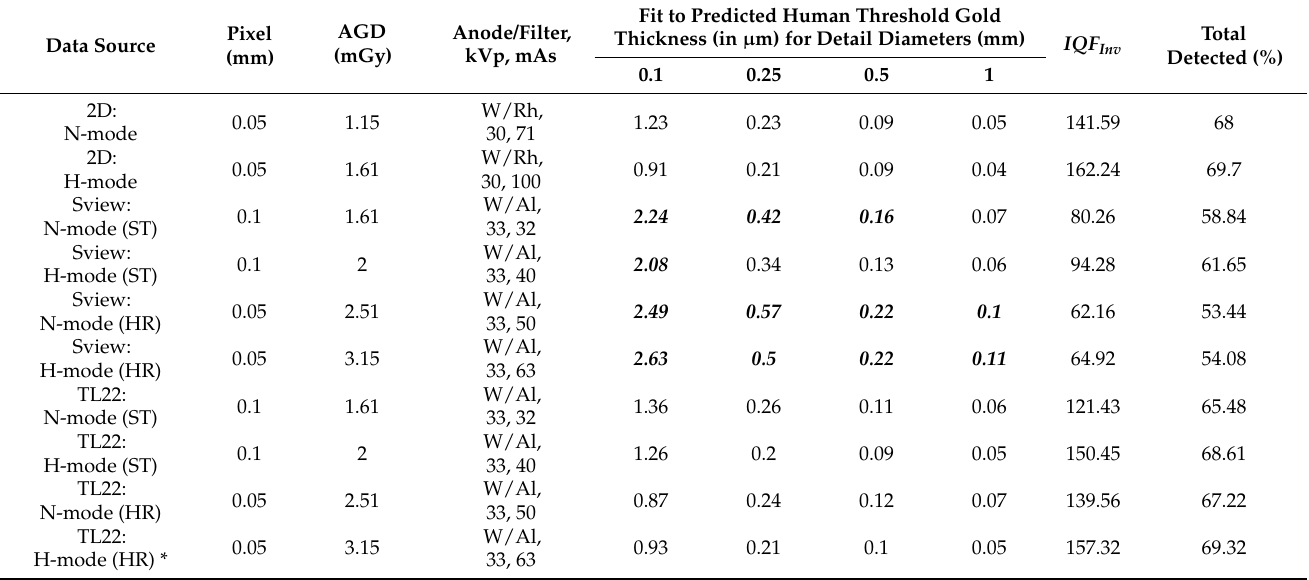
Table 4. The results of automatic image quality evaluation of CDMAM images acquired with the Amulet Innovality DBT mammography unit, along with information about the exposure parameters and average glandular dose (AGD) values, as calculated by the mammography unit. Bold italics denote values above the EUREF acceptable